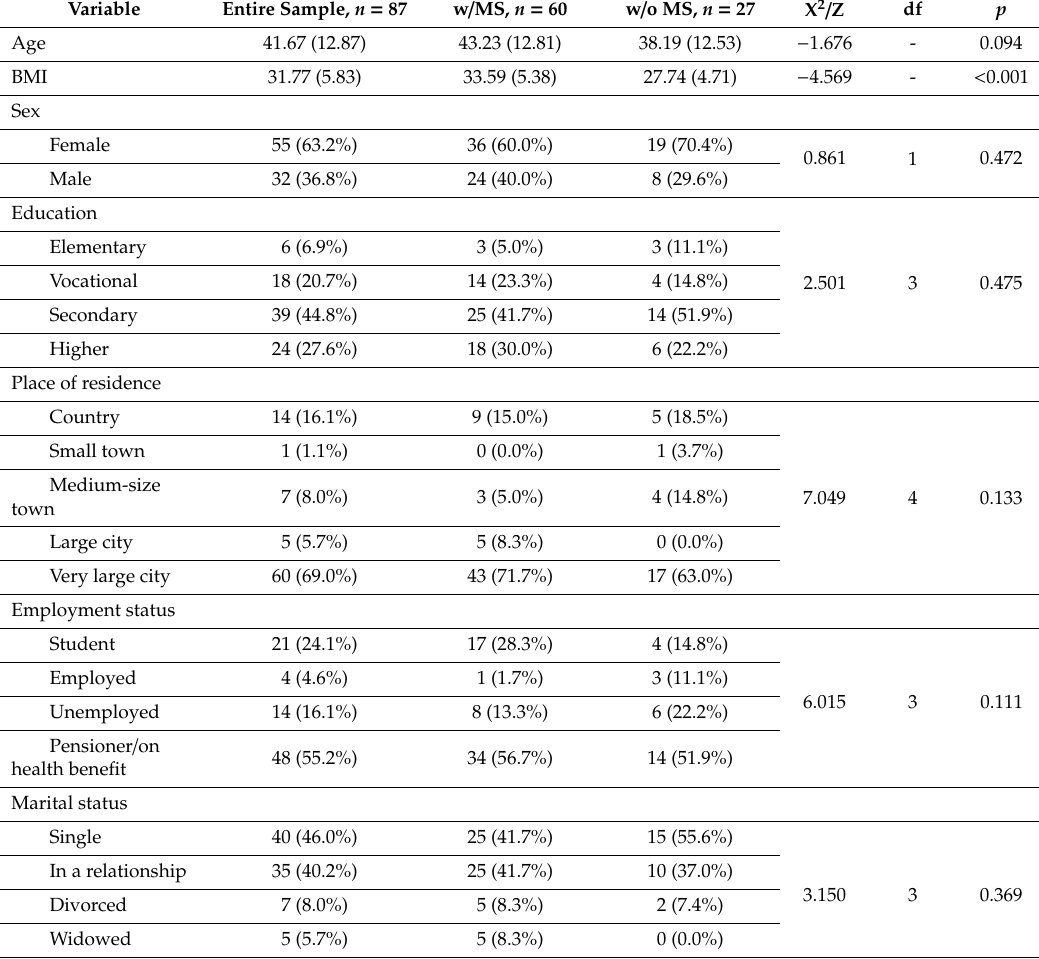
Table 1. Sociodemographic characteristics of the sample, N (%) or M